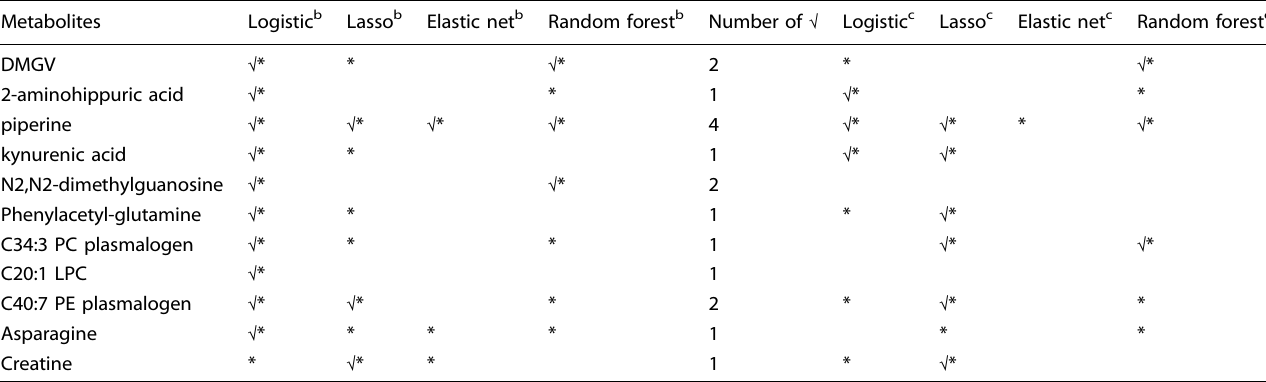
Table 2. All metabolites that met q -value < 0.2 (marked as √ in the table) in at least one primary model analysis that adjusts for matching factors (*marks p -value < 0.05 a ). Metabolites